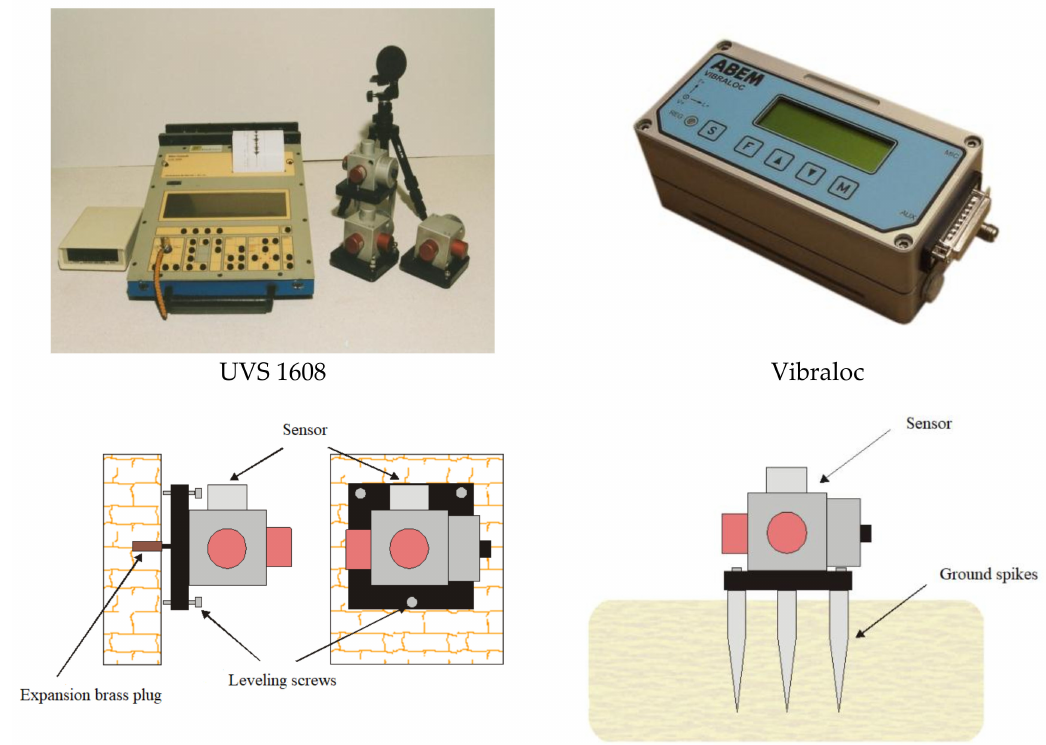
Figure 4. Vibration and airblast wave meters and the method of fixing the sensors to the foundation in the ground.